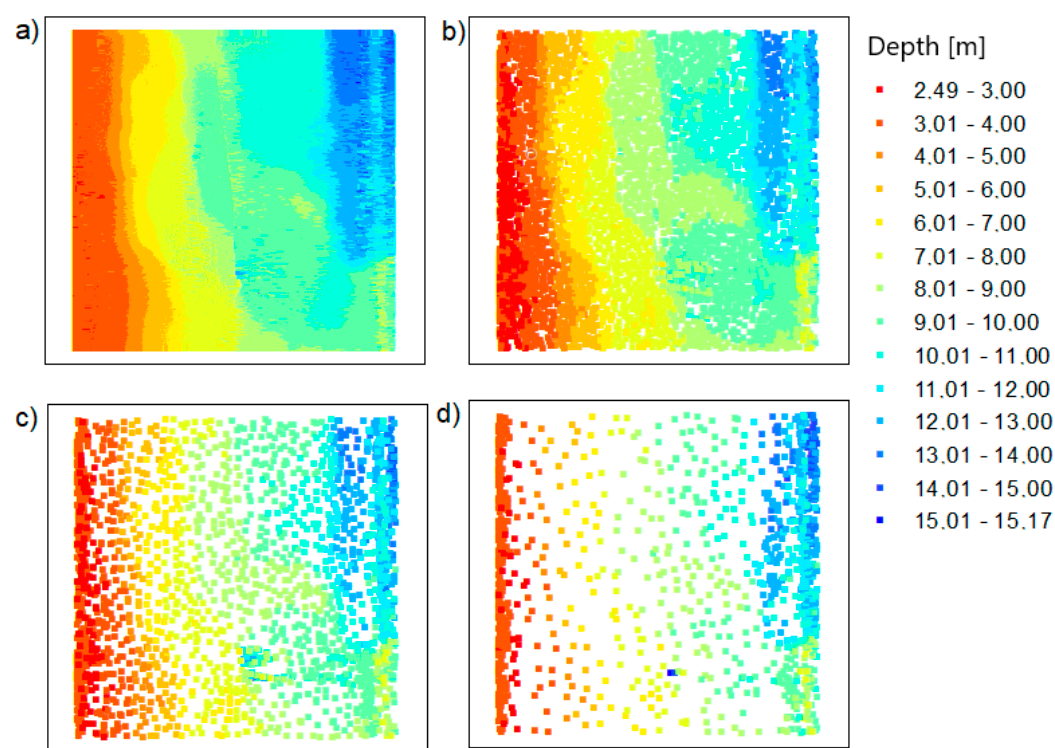
Figure 8. The datasets for the LNG port area: ( a ) raw dataset; ( b ) integrated dataset no. 1; ( c ) integrated dataset no. 2; ( d ) integrated dataset no. 3.